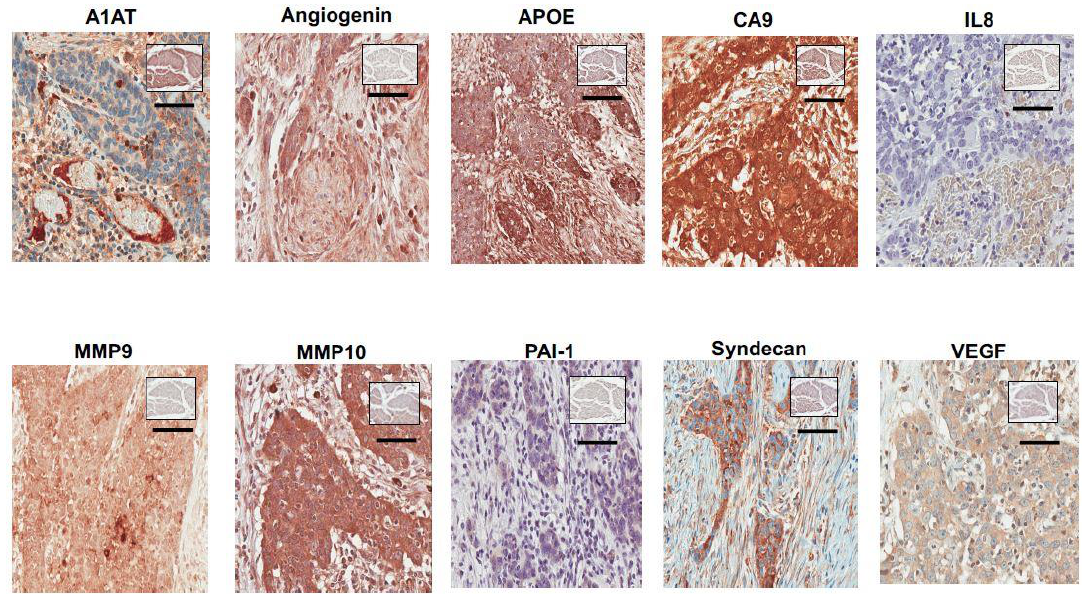
Figure 1. Representative expression status for ANG, CA9, MMP9, MMP10, A1AT, APOE, SDC1, VEGFA, PAI1 and IL8 in high-grade non-muscle invasive bladder tumor. Representative expression status for ANG, CA9, MMP9, MMP10, A1AT, APOE, SDC1, VEGFA, PAI1 and IL8 levels in benign tissue noted in square insert image. All images were captured at 400× magnification.